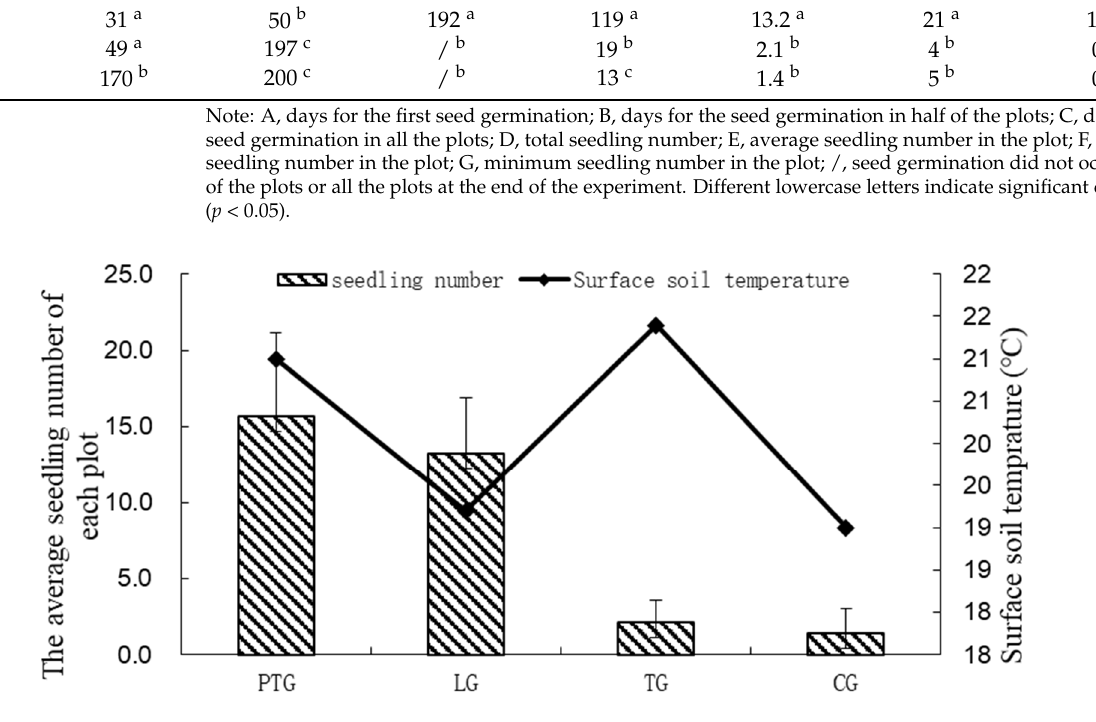
Figure 6. Effect of soil surface temperature on the number of emerged seedlings in the soil seed bank under different photo-thermal treatments.